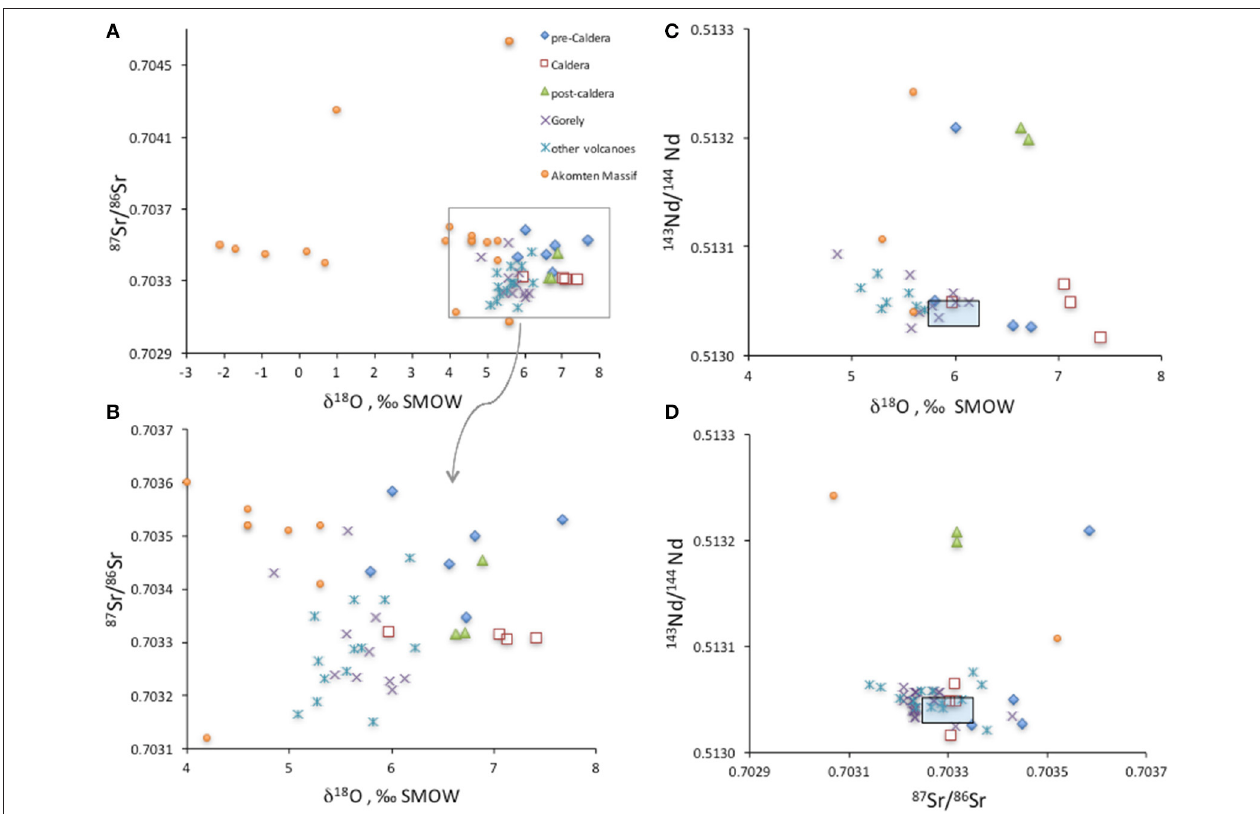
FIGURE 7 | Sr, Nd, and O isotopes in rocks from Karymshina Volcanic Complex in comparison to neighboring volcanoes, and basement rocks (Akhomten granite massif, and Ganal series metamorphics). Small rectangles in (C,D) indicate mantle derived basalts and products of their differentiation, and regional Sr and Nd isotopic values from central part of Eastern volcanic front Churikova et al. (2001) and Bindeman et al. (2004). (A) Regional pattern, showing low- δ 18 O and diverse Sr isotopes in hydrothermally altered crust from Akhomten and overall normal to slightly high- δ 18 O values of Karymshina magmas. (B) Zoom in on Karymshina and local volcanoes data showing low δ 18 O magmas from multi-caldera Gorely volcano (Seligman et al., 2014) and decrease of Sr isotopes from pre to postcaldera stage. (C) Nd vs. O, and (D) Nd vs. Sr isotopes showing that isotopic ranges of magmas in and around Karymshina are best explained by isotopically diverse